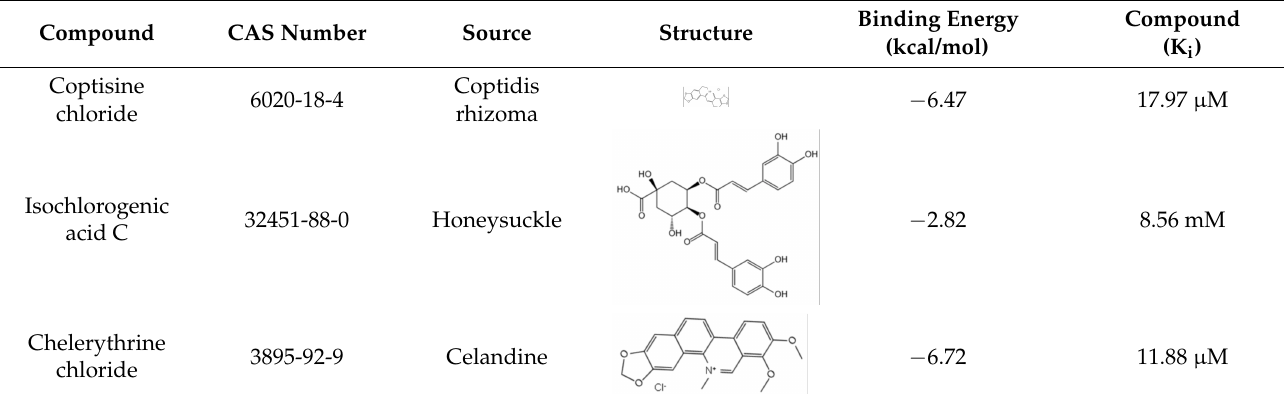
Table 1. Docking parameters of UreG with coptisine chloride, isochlorogenic acid C and chelerythrine chloride.